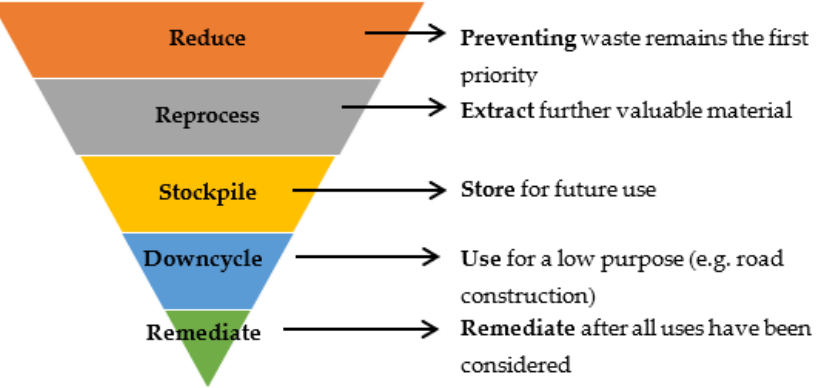
Figure 1. New hierarchy for mine waste management based on Lèbre and Corder (2015).